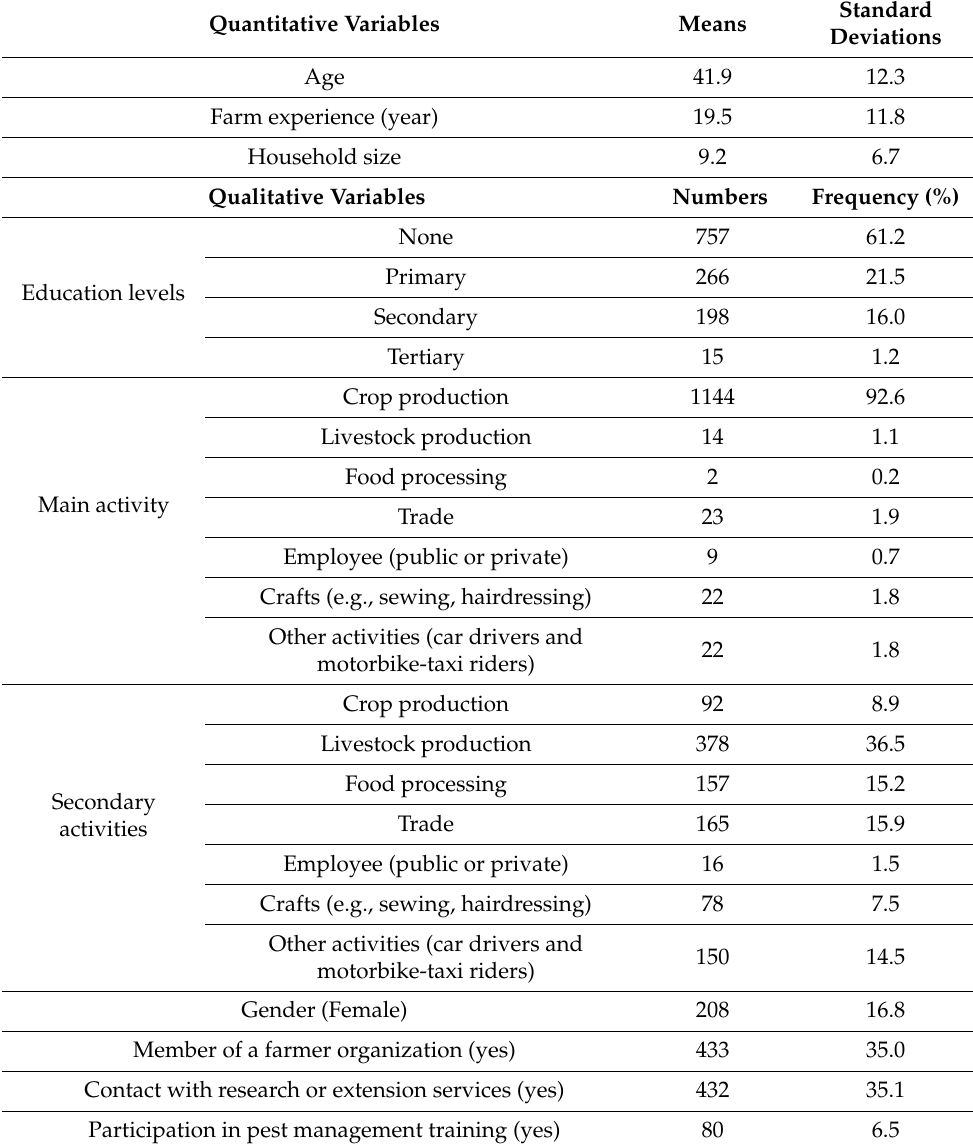
Table 2. Descriptive statistics on the socio-economic profiles of the surveyed